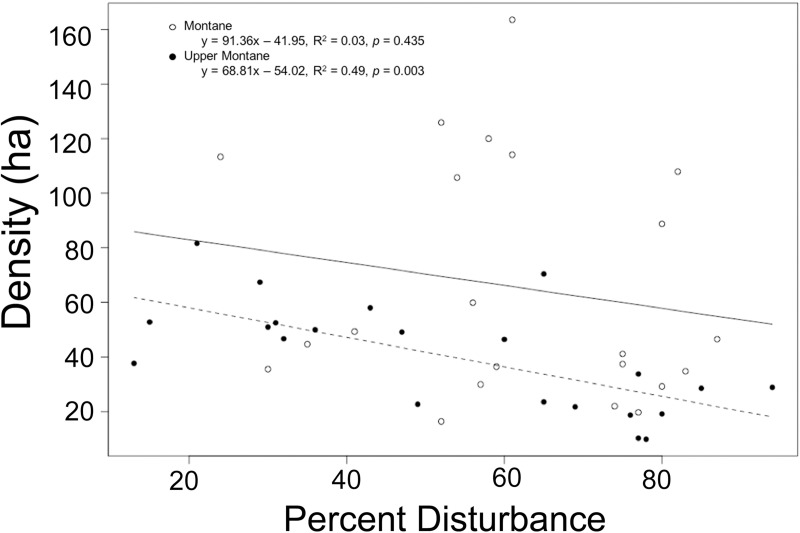
Tree density decreases with increasing percent disturbance in upper montane forests.Description: Tree density (ha-1) decreased significantly with increasing percent disturbance in the upper montane forest sites, however; density did not vary significantly with disturbance in the montane sites.